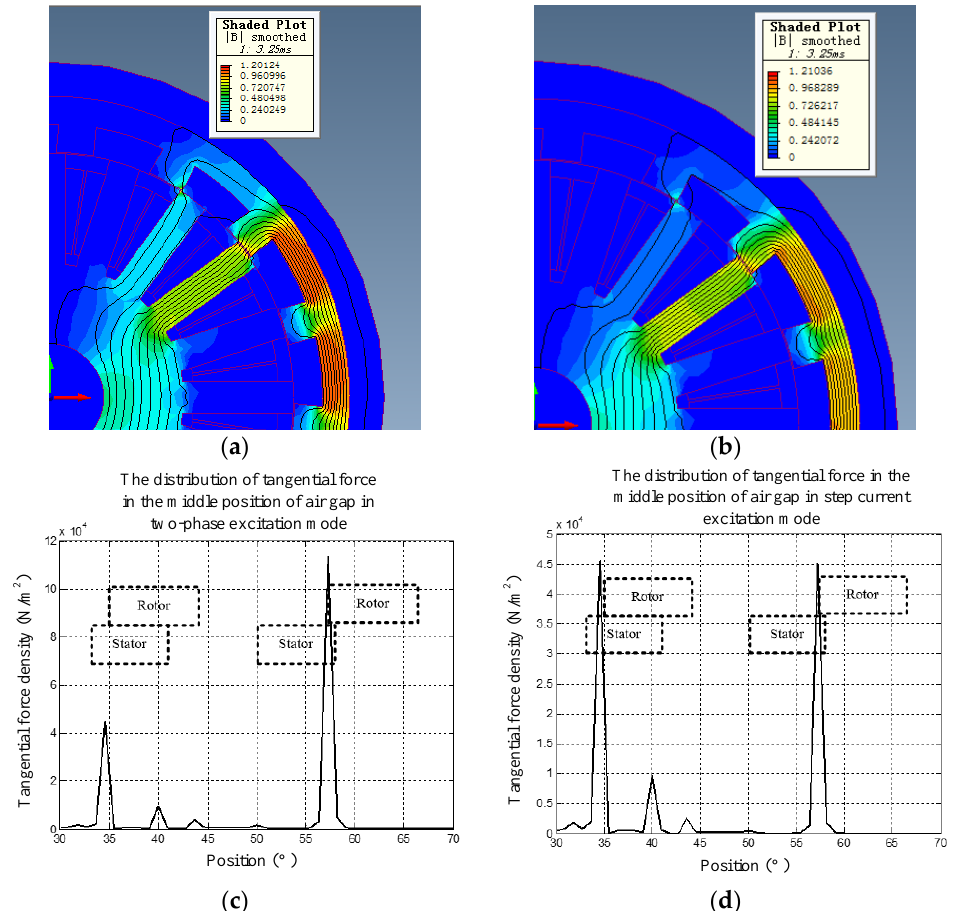
Figure 6. Two excitation modes: ( a ) the distribution of magnetic flux in two-phase excitation mode; ( b ) the distribution of magnetic flux in step excitation mode; ( c ) the tangential force in two-phase excitation mode; ( d ) the tangential force in step excitation mode. The torque versus position curve was simulated, where the speed of OSRM was set as 300 rpm, the rated current I 2 was taken as 5 A, finite element simulation is carried out for different c and ∆ θ , as shown in Figure 7. The optimization process start with tuning of ∆ θ with each fixed I 1 value, as illustrated in Figure 7.